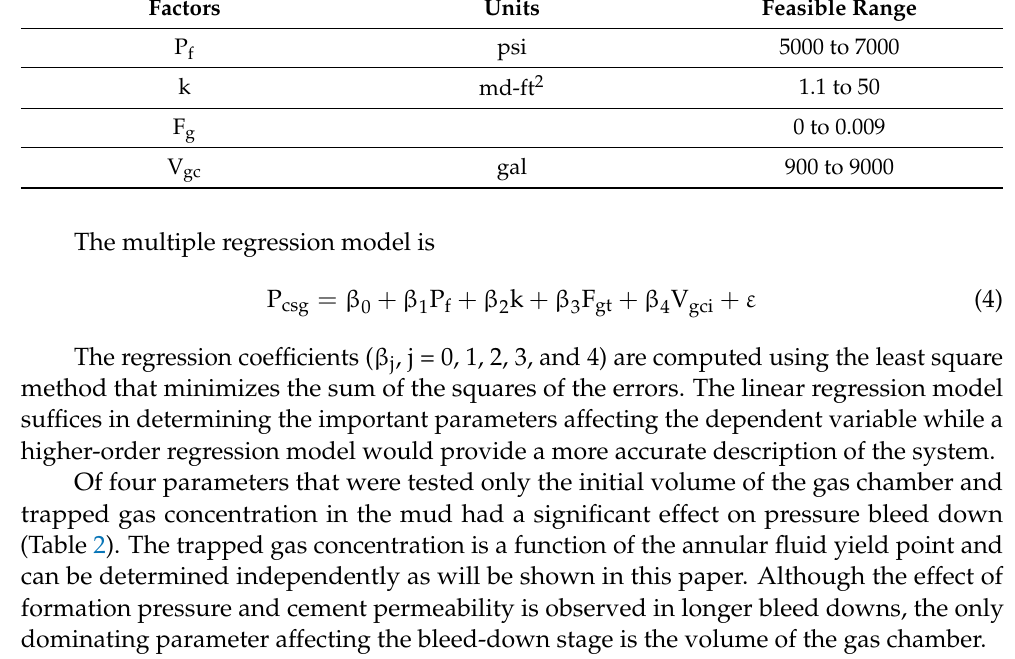
Table 1. Low and high values for five parameters affecting buildup and bleed-down.